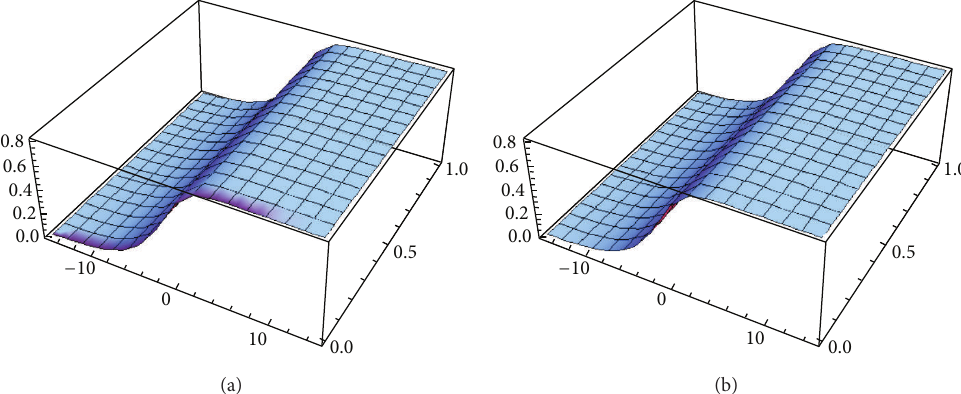
Figure 11: Graph of the solution (41) corresponding to the values 𝛼 = 0.05 , 𝛼 = 0.85 , respectively, when 𝑘 = 1 , 𝑝 = 3 , 𝛽 = 2 , −15 < 𝑥 < 15 , and 0 < 𝑡 < 1 .